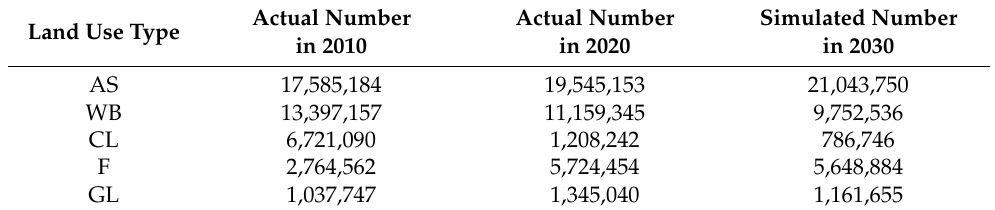
Table 11. Numbers of the pixels of different land use types in 2010, 2020, and 2030. Land Use Type